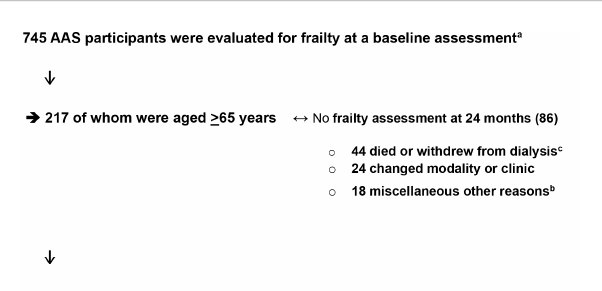
FIGURE 2 Derivation of Study Cohort: Older Persons with Dialysis-dependent CKD. 745 AAS participants were evaluated for frailty at a baseline assessment. a. ↓ ! 217 of whom were aged ≥ 65 years ↔ No frailty assessment at 24 months (86). 44 died or withdrew from dialysisc. 24 changed modality or clinic. 18 miscellaneous other reasons. b. ↓ ! 131 evaluated for frailty again at 24 months post-baseline !! Study Cohort. AAS, ACTIVE-ADIPOSE Study a. Kutner et al. (7). b. Miscellaneous other reasons were observed for 18 participants: cognitive impairment; cancer; “ too sick ” ; study withdrawal. c. Baseline frailty status of these 44 participants who died (n=41) or withdrew from dialysis (n=3): Robust=3; Pre-frail=23; Frail=18.